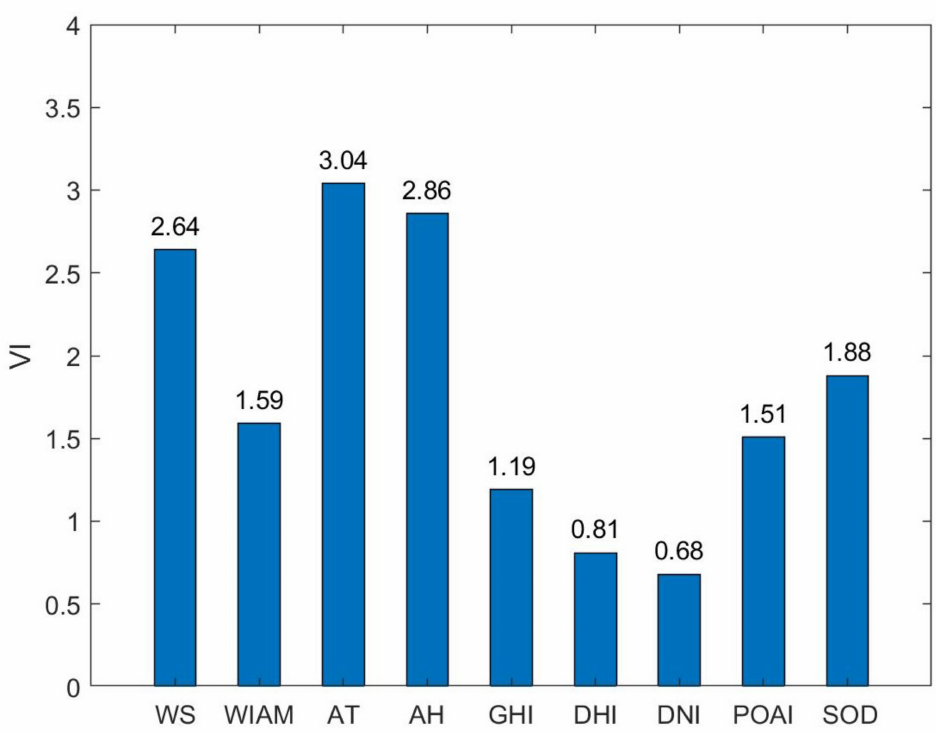
Figure 6. VI of each